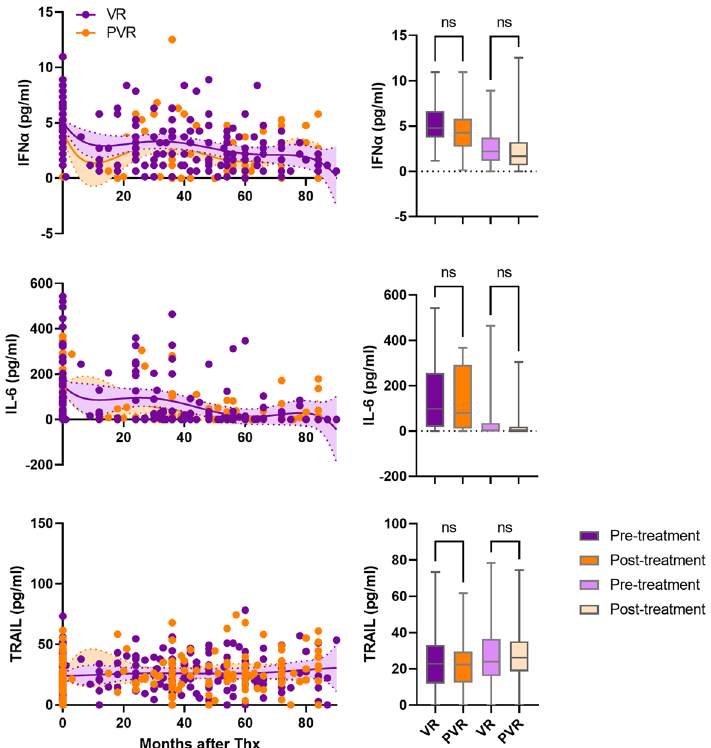
Figure 6. Levels of cytokine levels in VR patients and PVR patients. Circulating IFNα, IL-6, and TRAIL levels in VR (purple dots) patients and PVR patients (orange dots). Shaded areas indicate 95% confidence intervals around the regression lines. Bar graphs represent concentration of each cytokine in pre-treatment (dark purple), post-treatment (light purple) of VR and pre-treatment (dark orange), post-treatment (light orange) of